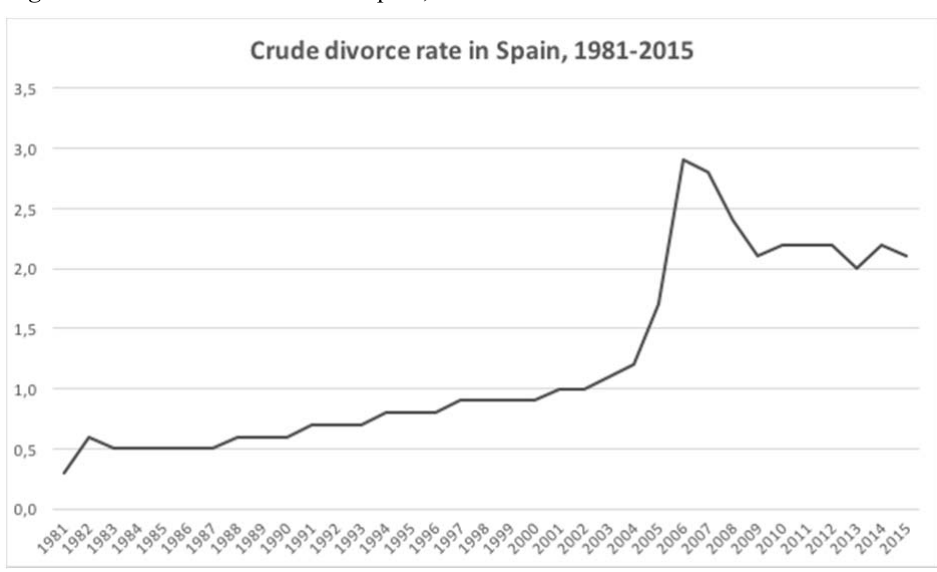
Figure 1 : Crude divorce rate in Spain,